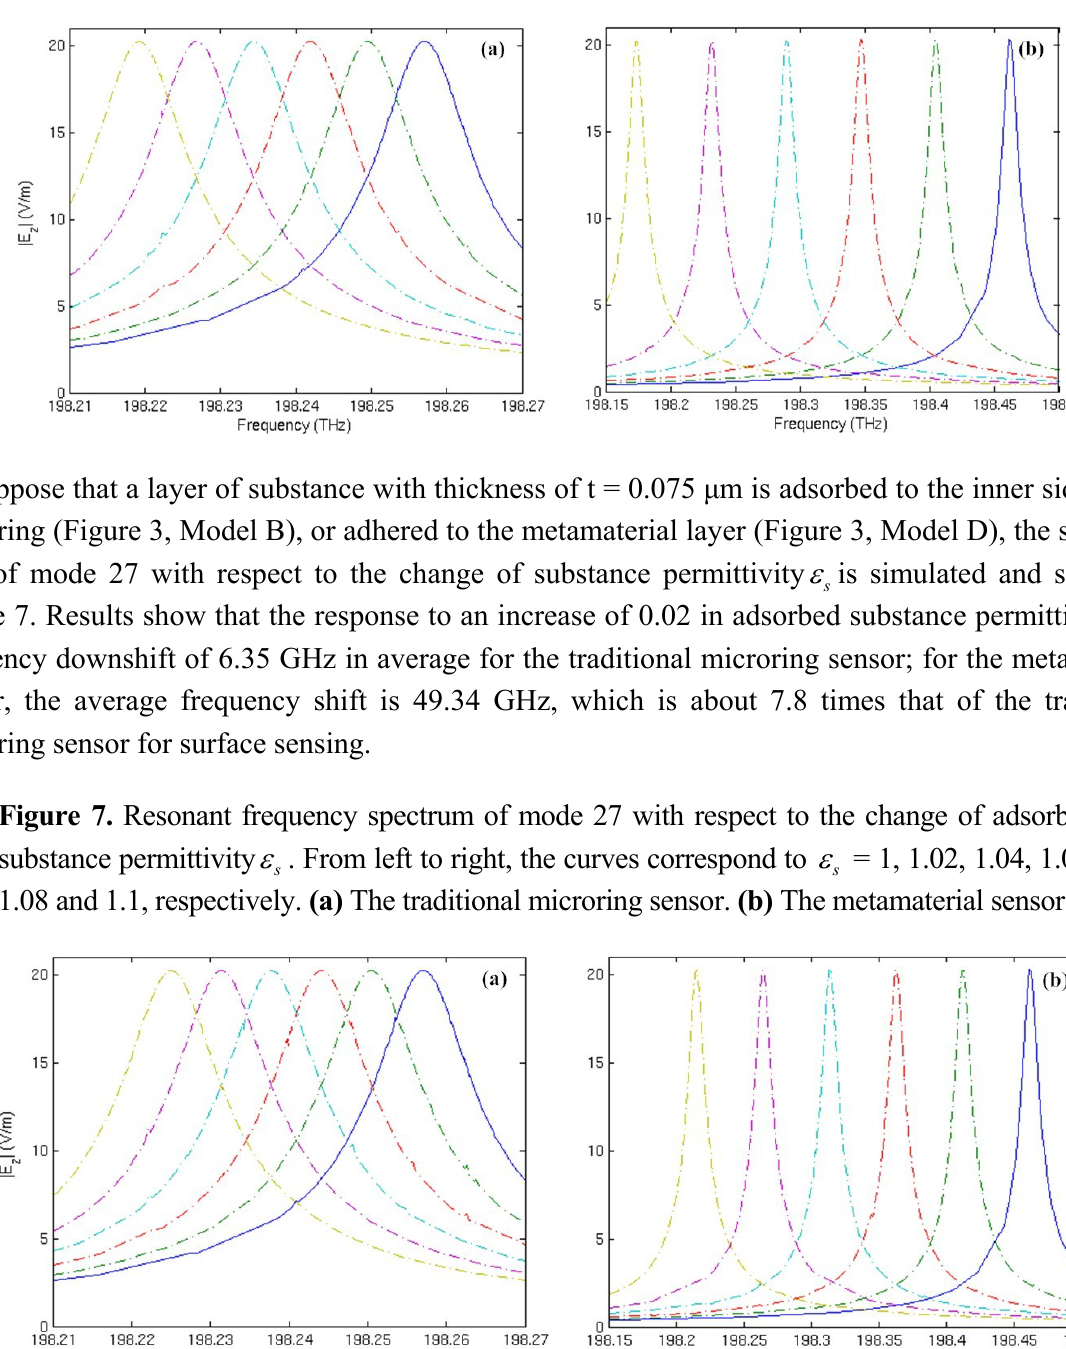
ε = 1, 1.02, 1.04, 1.06, s